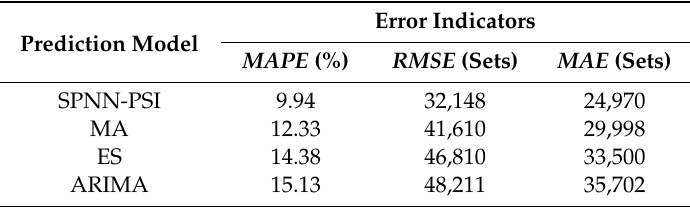
Table 3. Error indicators of each prediction model on the VS dataset.